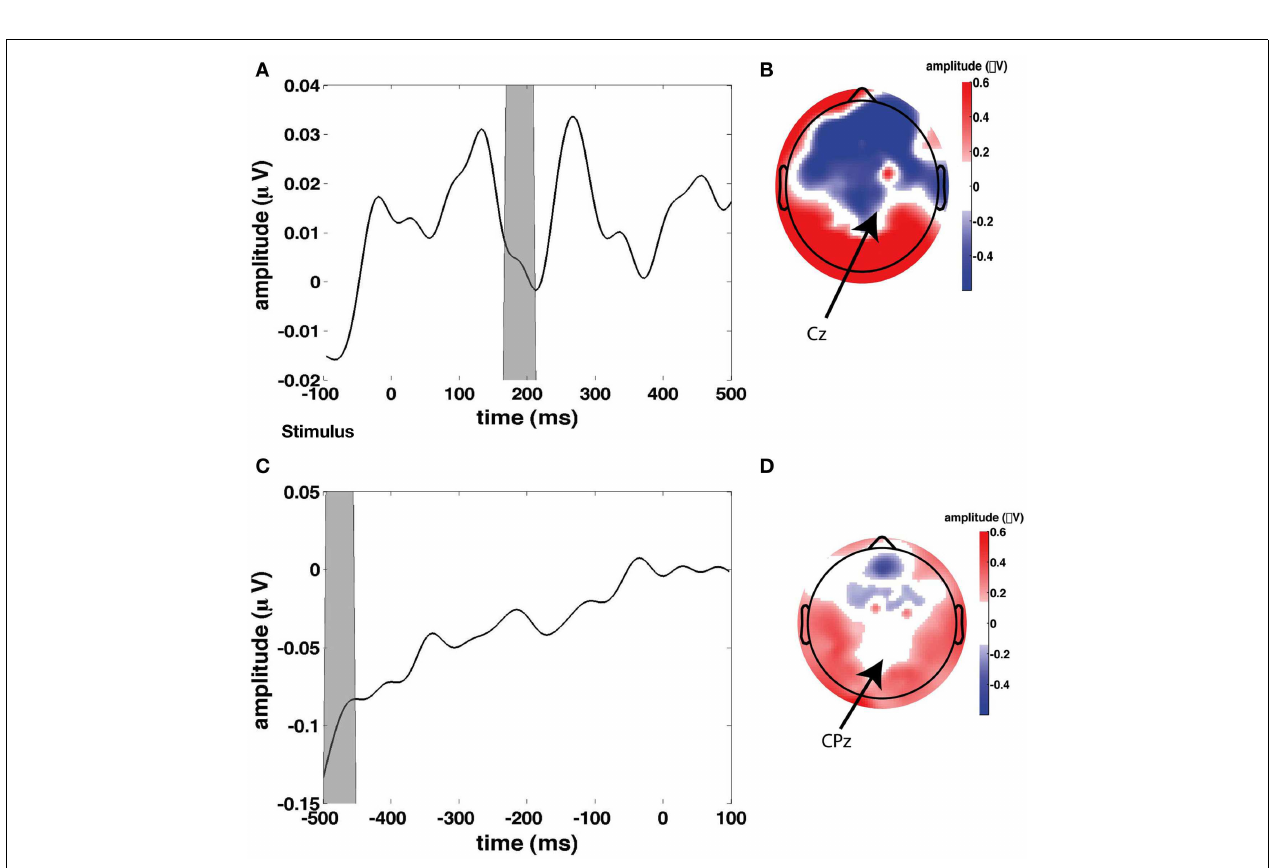
course in (A) which represents the first stimulus-evoked peak. (C) Grand average response-locked ERP. (D) Topographical plot of ERP amplitude in the gray time window in the time course in (C) which represents the maximum response-related